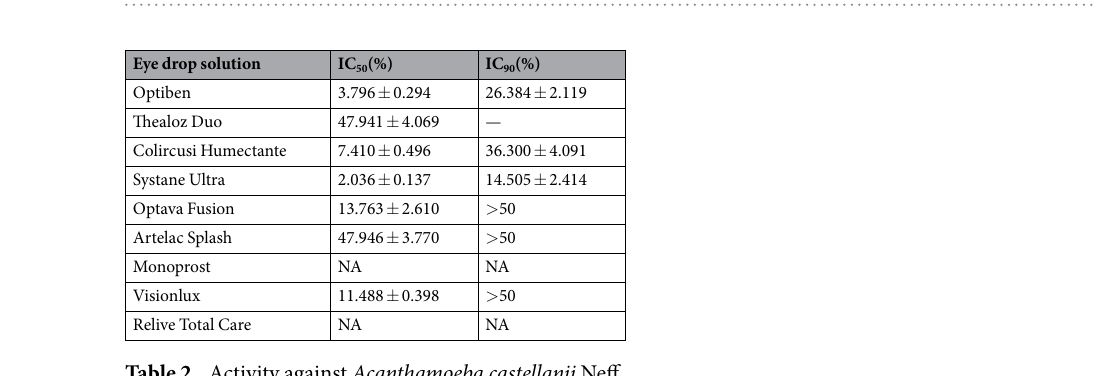
Table 1. Eye dry drops Composition.